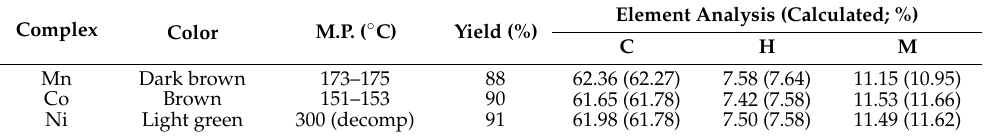
Table 1. Physical properties and elemental content of ibuprofen–metal complexes obtained according to Scheme